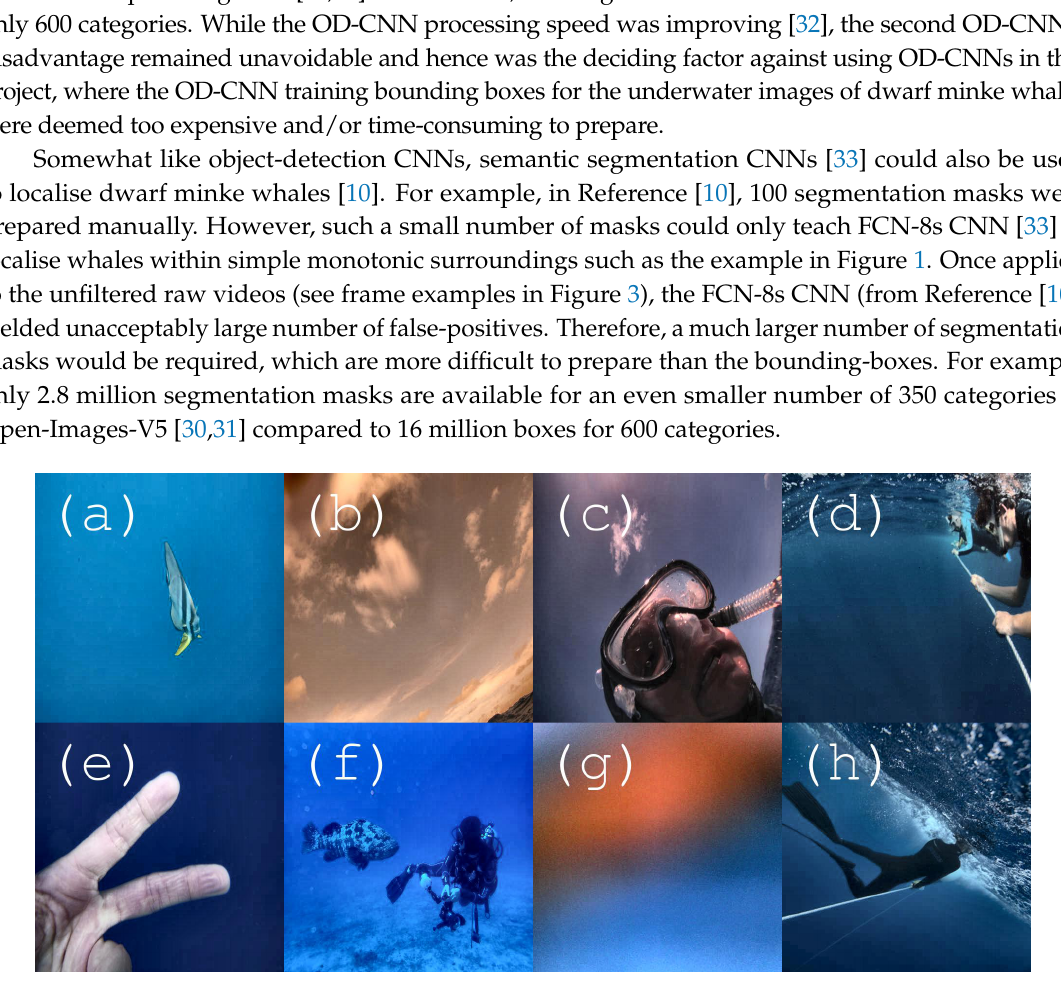
Figure 3. Sub-figures: ( a – h ) are examples of false-positive classification errors, which were the negative test images incorrectly predicted as positives (contain a whale) by MWD-v1 after the first train-predict